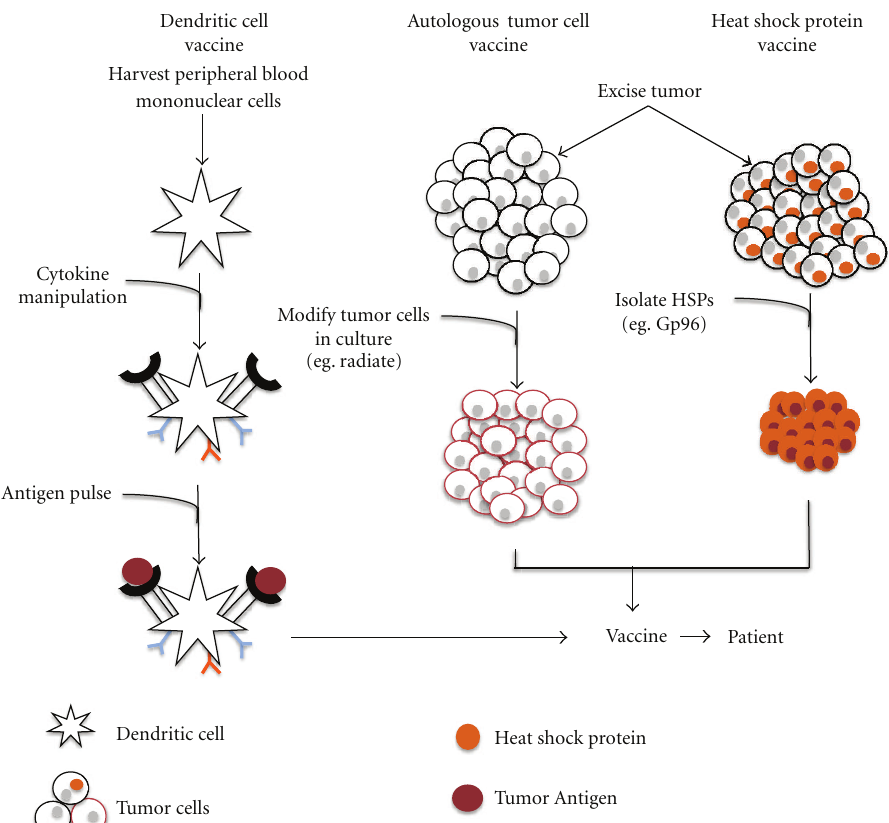
Figure 2: Vaccine Strategies for GBM. (From Left) Dendritic cell vaccine: peripheral blood mononuclear cells are isolated from the patient and cultured ex vivo . Cytokines are added to culture to activate the DCs. The matured DCs are pulsed with tumor antigen and then added to the vaccine preparation. Autologous tumor cell vaccine: after tumor removal, tumor cells are cultured. In some cases, these cells are modified (e.g., radiation, chemical) and then injected back into the patient. Heat shock protein vaccine: after tumor removal, tumor cells are cultured and specific heat shock proteins (e.g., Gp96) are isolated and purified. The proteins are then added to the vaccine preparation and injected into the